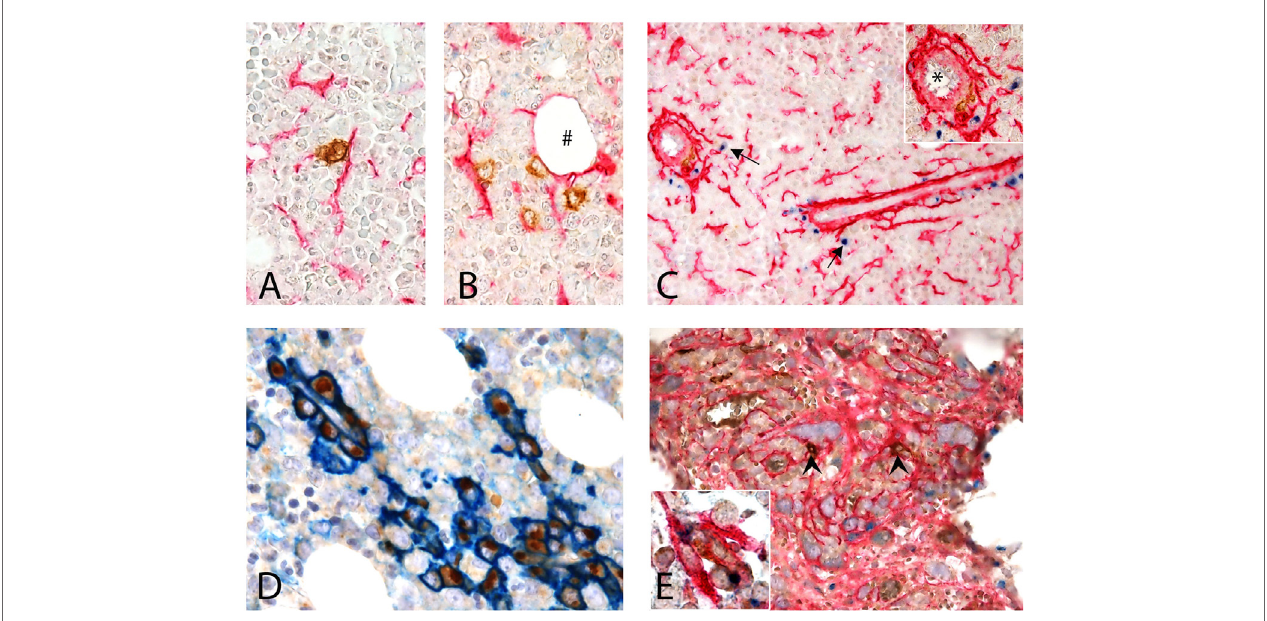
FigUre 6 | Interaction of CD1c + dendritic cells (DCs) and CD271 + mesenchymal stromal cells (MSCs) in human BM. (a–D) Normal BM. (a,B) Show the interaction of CD1c + (brown) DCs with CD271/NGFR + (red) MSCs in the interstitium of normal hematopoietic matrix, even near an adipocyte (#). (c) Shows this interaction next to a vessel (*) in the proximity of which osteopontin (OPN) (blu) is produced (arrows). Double immunostaining for CD38 (blue) and OPN (brown) showed that plasma cells are the major expressors of OPN in normal human BM (D) . (e) BM with myelofibrosis: intertrabecular spaces show dense network of CD271 + MSCs (red) that interact with scattered CD1c + DCs (brown, arrow heads); in this contest, OPN (blue) production can be detected [ (e) ,